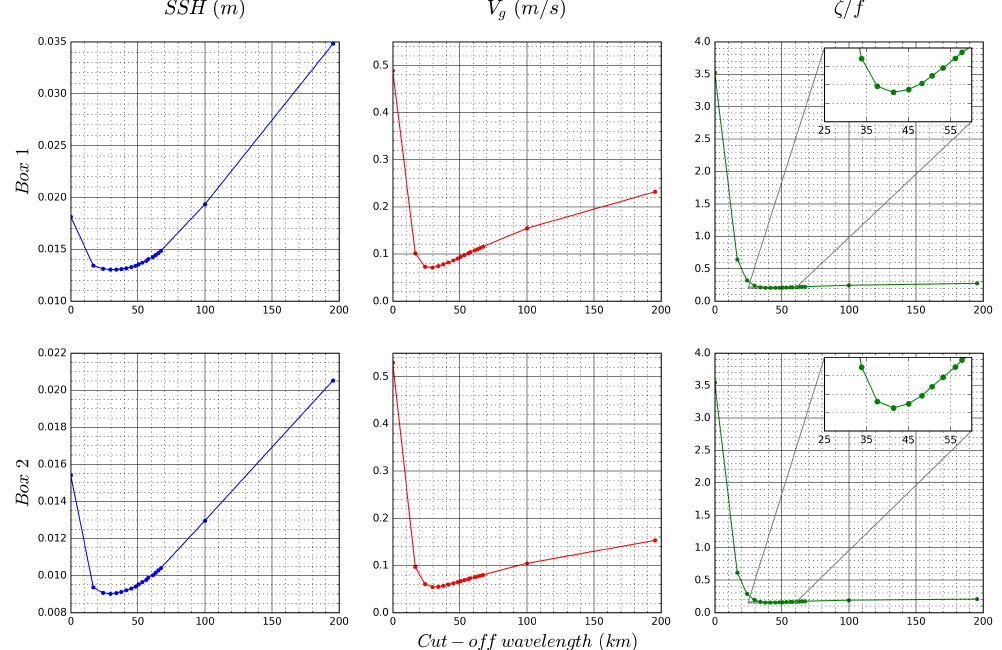
Figure 15. RMSEs of the different variables against the filter’s cut-off wavelengths applied to SSH, for pass 15 ( top ) and pass 168 ( bottom ) of cycle 2. Insets show zoom of marked region for better observation of the curves’ minimum